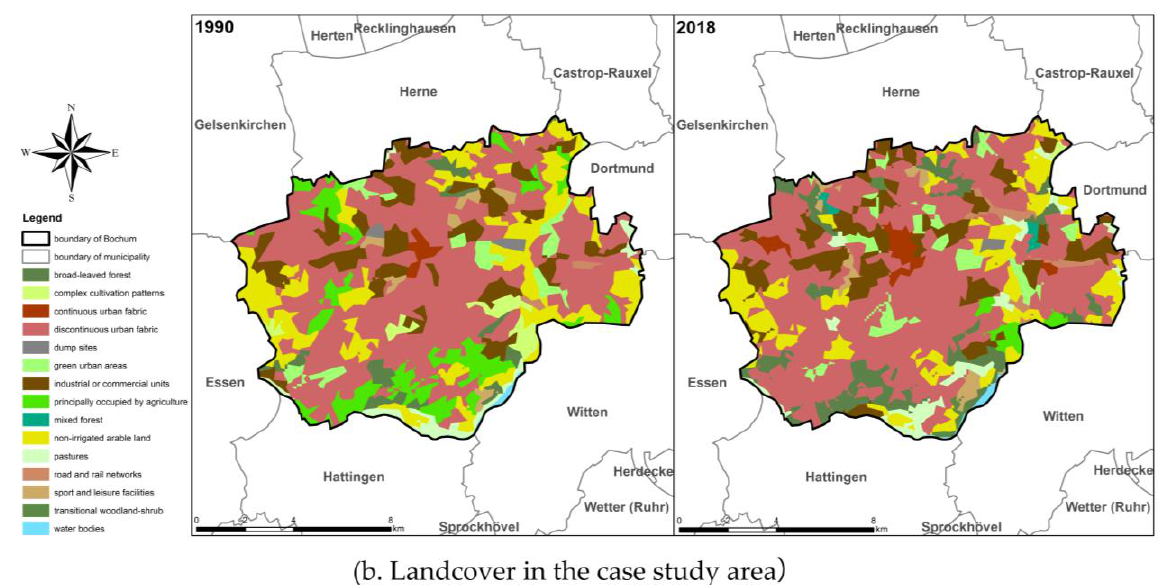
Figure 2. Overview of the study area.